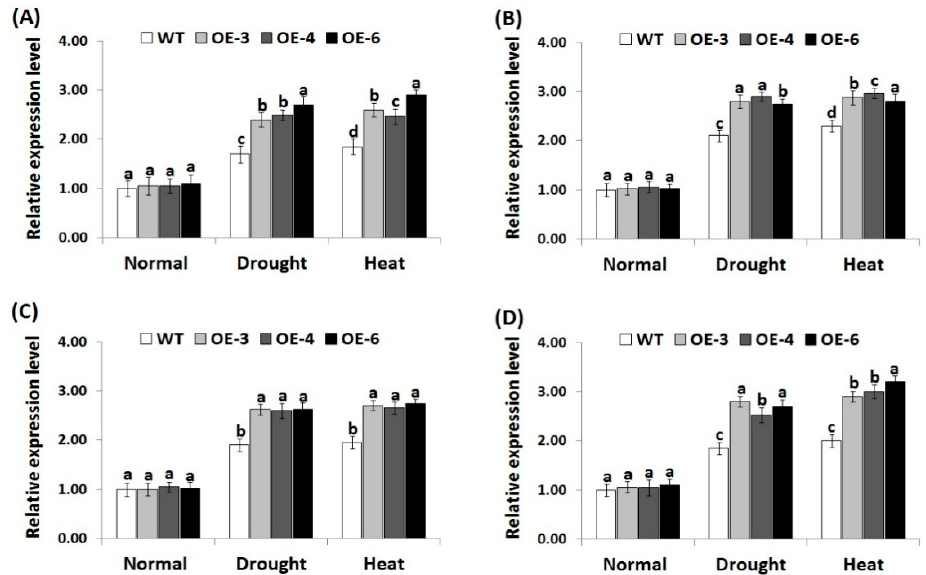
Figure 6. Expression levels of OsCATA ( A ), OsCATB ( B ), OsAPX2 ( C ), and OsSOD-Cu/Zn ( D ) genes in the wild-type and transgenic rice plants overexpressing OsRab7 subjected to normal, drought, and heat stress conditions. Data are means ± SE ( n = 3). Different letters above the columns indicate significant differences between rice lines ( p ≤